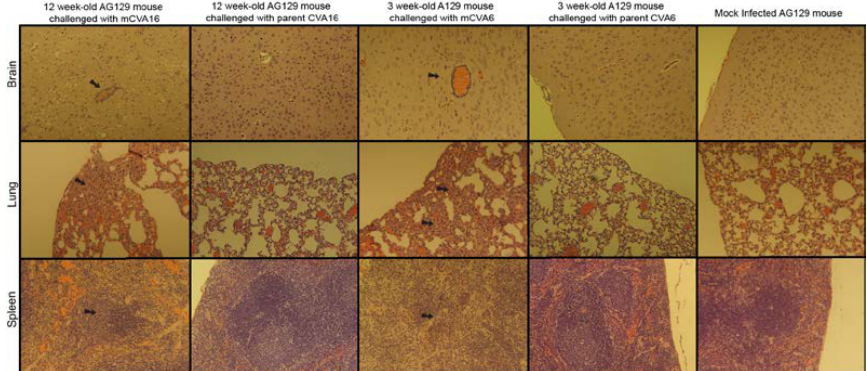
Figure 2. Histopathological changes associated with interferon deficient mice challenged with mouse adapted CVA16 and CVA6. Pictures of tissues were done with a 10× objective. First column shows tissues from a 12 week-old AG129 mouse challenged with mCVA16. The third, tissues from a 3 week-old A129 mouse challenged with mCVA6. Perivascular cuffing is observed in the brain, interstitial pneumonia in the lungs, and lymphoid depletion in the spleen of mice infected with both mouse adapted viruses (see black arrows). The last column displays tissues from a mock infected mouse. Mice challenged with the parent strains of each virus did not show clinical signs of disease or pathology in any tissues.